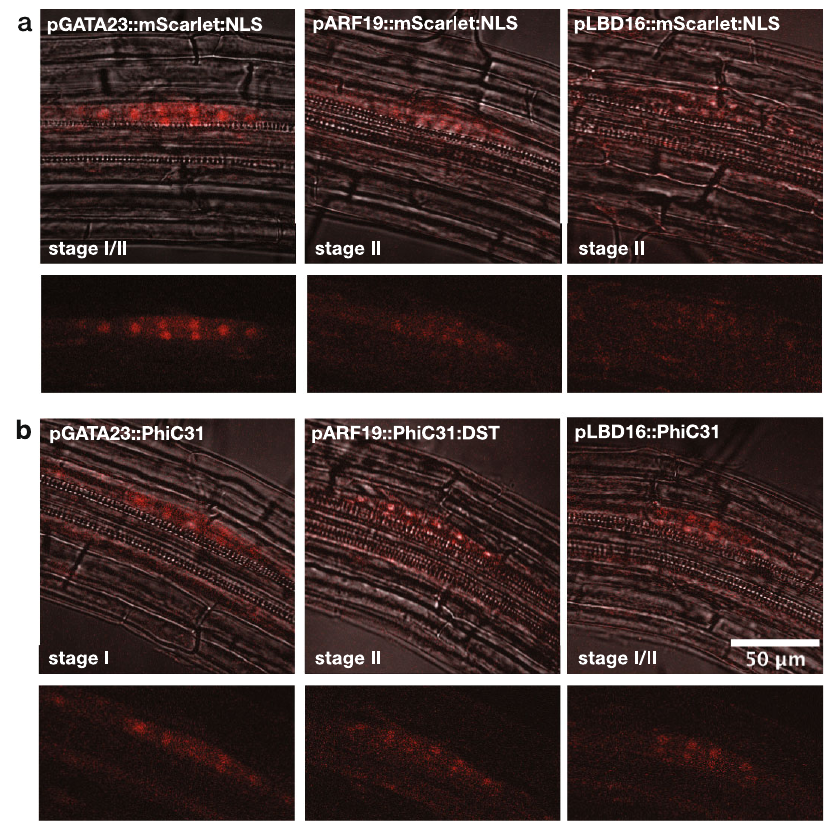
Fig. 5 | Confocal imaging of transcriptional reporters and integrase-based recorder in early-stage lateral roots. a , b Overlays of bright fi eld and red fl uor- escence channels from a single frame are shown above an image of the red fl uor- escence channelalone.Foreachimage,thedevelopmentalstageof thelateralroot primordium is indicated. a Transcriptional reporter lines, composed of the